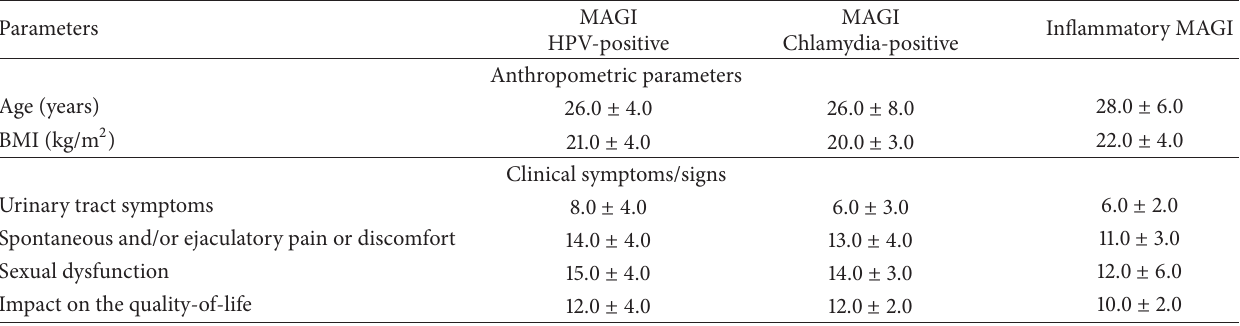
Table 1: Anthropometric measurements and clinical symptom scores in the three groups of patients with male accessory gland infection/inflammation (MAGI) enrolled in this study.